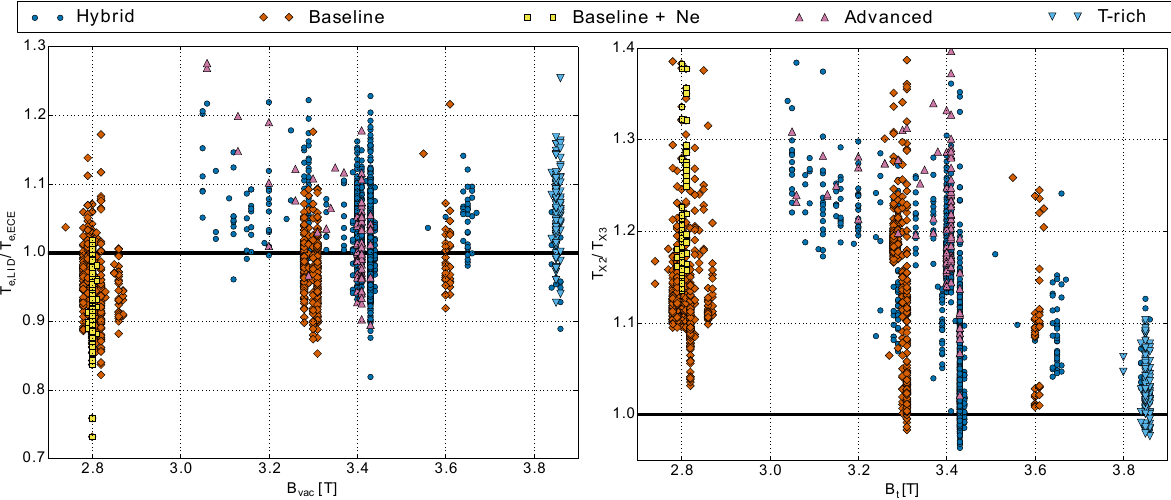
Figure 8: Ratio of ECE and LIDAR measurements (a) and ratio between the peaks of X2 and X3 emission (b) as a function of the vacuum magnetic field B v ac